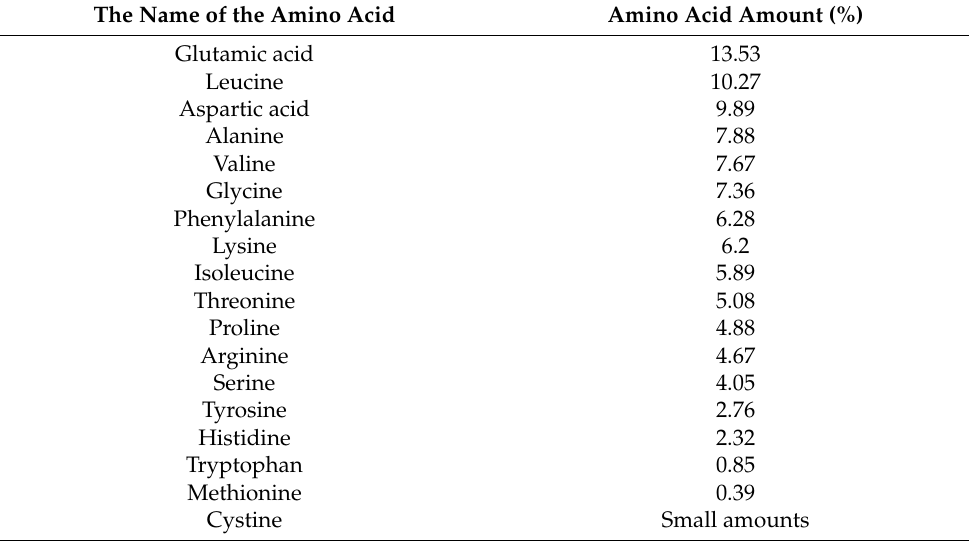
Table 1. Amino acid content in L. minor